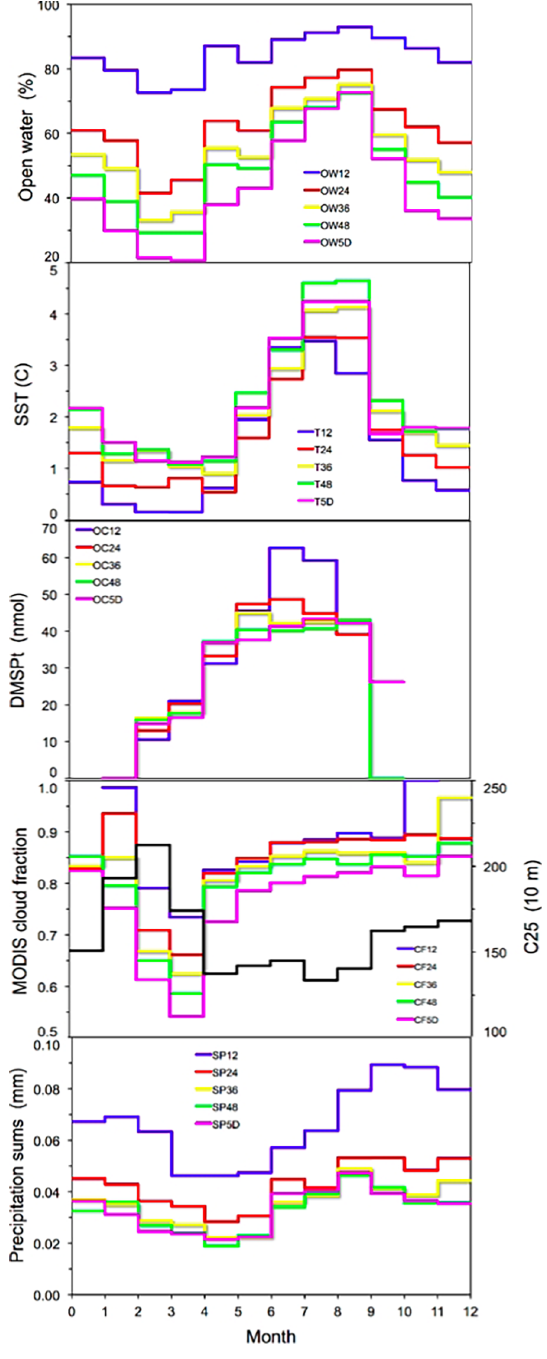
Figure 7. Monthly averages of environmental parameters averaged along back trajectories to Mt. Zeppelin. From top to bottom: OW12- 5D: open water in % during last 12, 24, 36, and 48h, and days 3–5 before trajectory arrival at Mt. Zeppelin. T 12-5D: same for sea sur- face temperature in ◦ C. OC12-5D: same for DMSPt in nmol in sur- face waters. CF12-5D: same for MODIS cloud fraction. SP12-5D: same for precipitation sums in millimeters. C 25 = 25% percentile of cloud base in